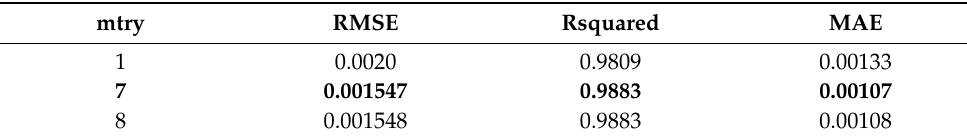
Table 9. Quantile random forest.